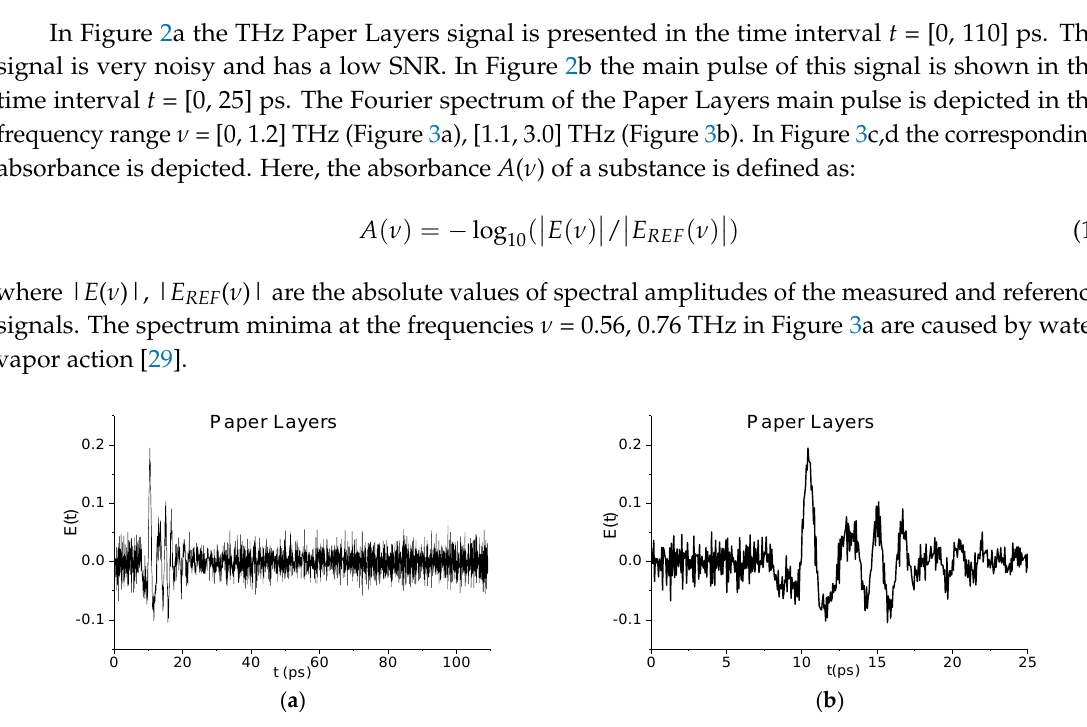
( d ) Figure 3. Fourier spectrum ( a , b ) and absorbance ( c , d ) of the main pulse for the signal Paper Layers in the frequency range ν = [0, 1.5] THz ( a,c ); [1.5, 3.2] THz ( b,d ) [29]. Therefore, the standard THz-TDS method, based on the spectrum analysis only, is insufficient for the substance identification under real conditions because it detects the presence of many dangerous substances in a neutral sample. We stress that at the same time, the SDA-method together with ICC allows us to show the absence of dangerous substances in this sample and to confirm the presence of paper spectral features in it, see [29]. To explain the physical mechanism for the appearance of false absorption frequencies in the THz signal transmitted through or reflected from the multilayered sample in the papers [34,37] we performed a computer simulation using 1D Maxwell's equations and matrix density formalism for a medium description. Below, we demonstrate the efficiency of the SDA-method for the detection and identification of a substance by using not only the absorption frequencies but also the emission frequencies. We consider a response of the substance covered by disordered structure. 3. The SDA Method Efficiency for the Detection of a Substance Covered by Disordered Structure In this section, we focus our attention on the spectral intensity evolution in time at the chosen frequency of the signal transmitted through or reflected from the disordered layered structure. The problem statement and the corresponding system of 1D Maxwell’s equations also are described in detail in [34,37]. All values ( t, ν, E(t), E(ν) , etc.) used in the sections below, are dimensionless. Of course, we will discuss the efficiency of using the emission frequency [37] for the